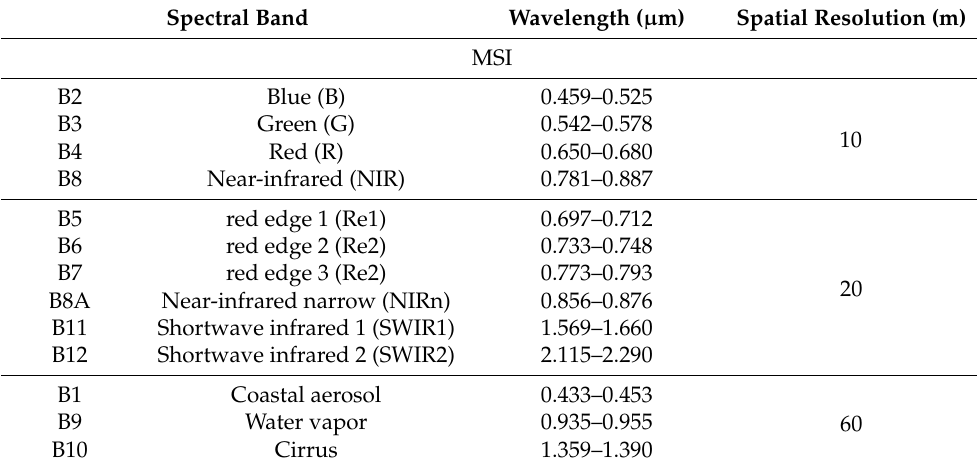
Table 2. Spectral and spatial characteristics of the MSI